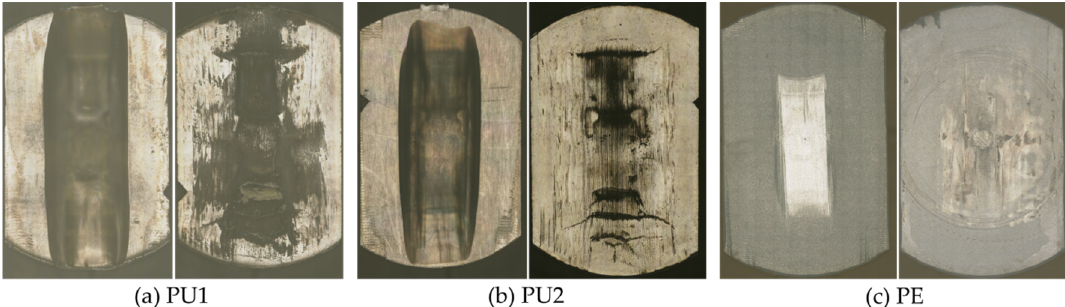
Figure 6. Overall wear of samples after loading in the rolling-sliding test bench. The straight line results from linear regression of the data for estimating the abrasion after 1 million cycles. Different to ISO 14243–1, the zero time point is used in this calculation.